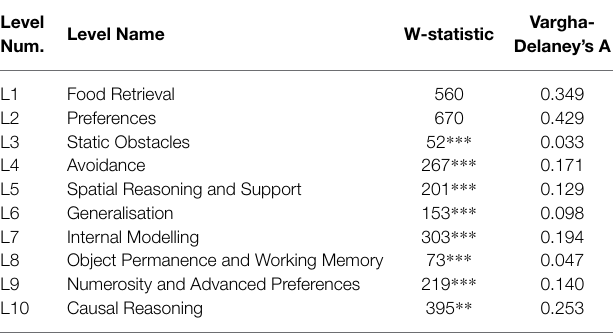
TABLE 3 | Mann–Whitney U-test statistics and Vargha-Delaney’s A comparing AIs and children on each level. Level Level Name Num.